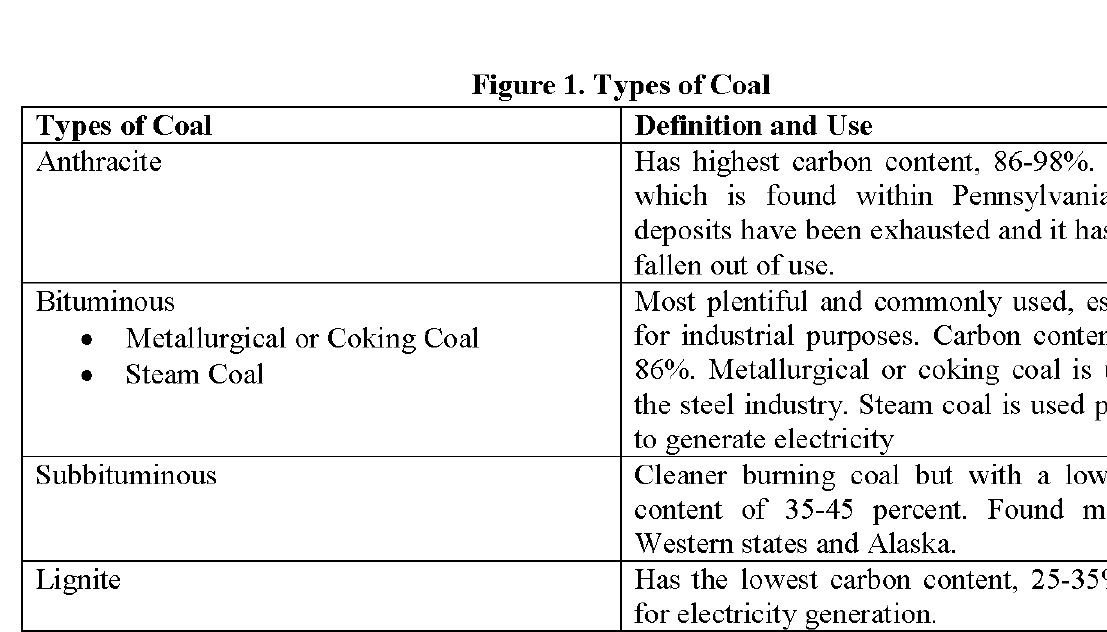
Figure 1. Types of